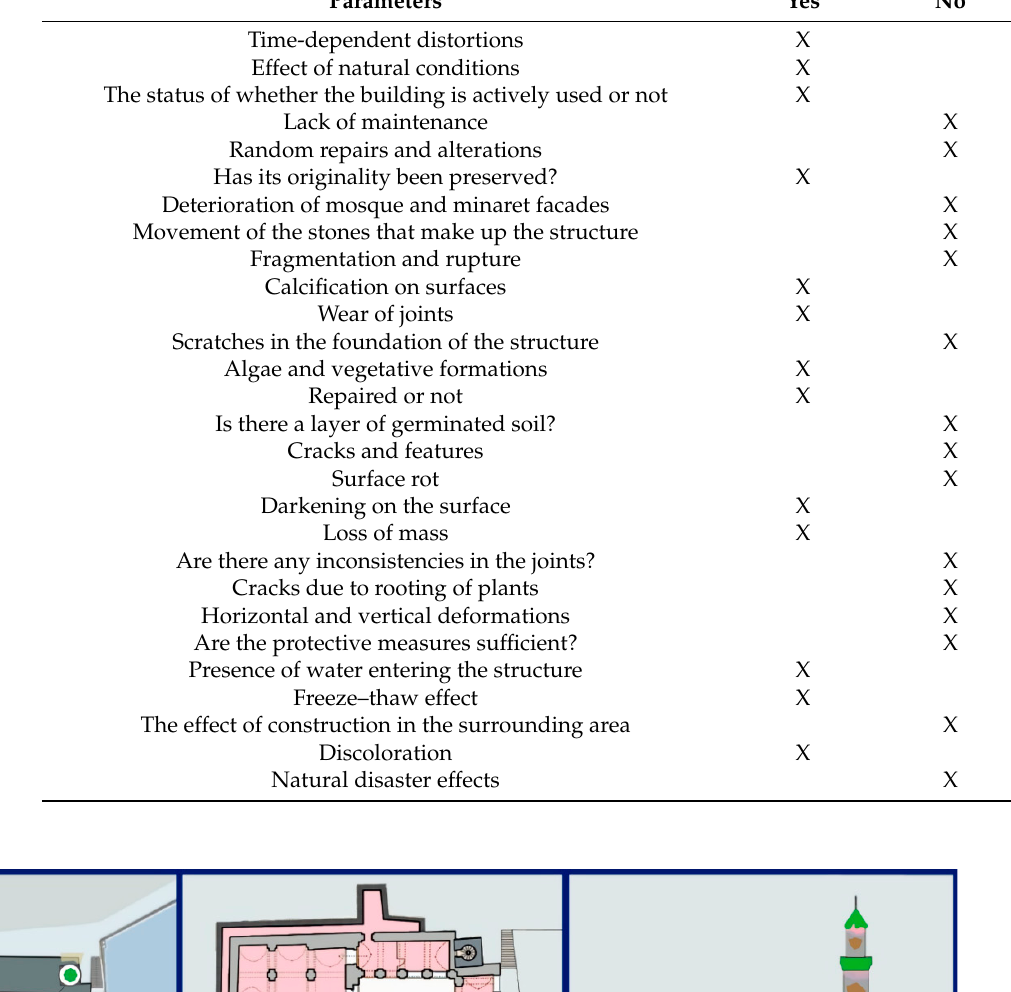
Table 2. Damages observed in Bitlis Ulu (Grand) Mosque and its minaret.